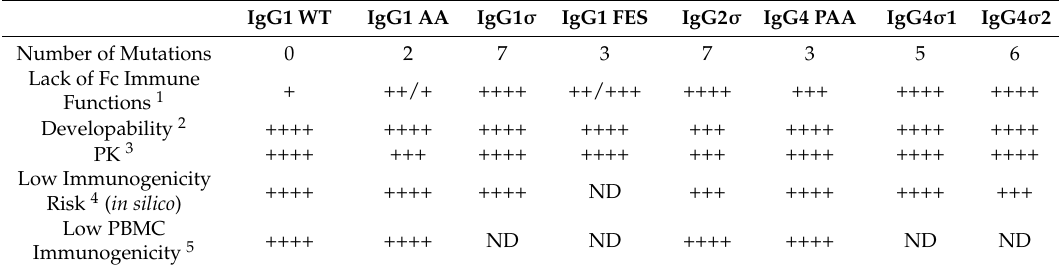
Table 8. Summary of Silent Fc